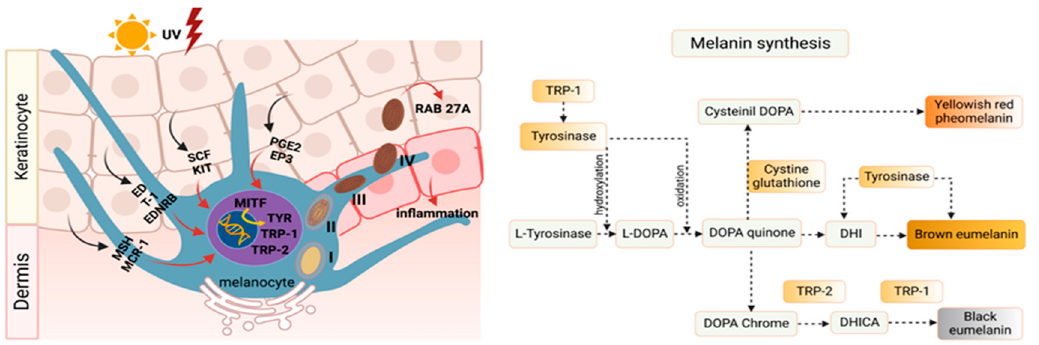
Figure 1. Synthetic pathway of melanin. Melanin synthesis begins with the catalysis of substrates L-phenylalanine and L-tyrosine to produce L-DOPA via phenylalanine hydroxylase (PAH), tyrosinase and, partially, tyrosinase hydroxylase 1 (TH-1). Pathways are then divided into eumelanogenesis or pheomelanogenesis. The other melanogenic enzymes are TRP-2 (DCT) and TRP-1 for eumelanogenesis.